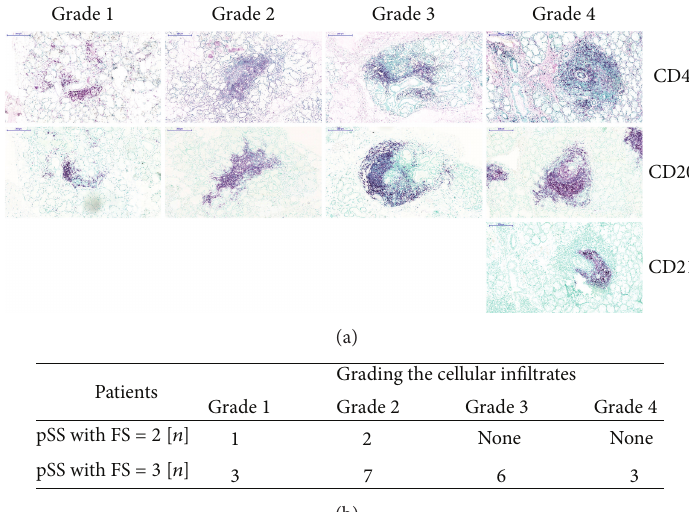
Figure 1: The classification of periductal inflammatory infiltrates with different levels of organization. (a) Immunohistochemical stainings of FFPE sections from representative examples of LSG sections. For rating the periductal lymphocytic infiltrates, paraffin specimens were stained for CD4, CD20, and in some cases CD21. We distinguished four different grades. Grade 1 displayed scattered T and B cells around the ducts. Grades 2 and 3 showed mild and more organized lymphocytic aggregates. Grade 4 indicated a highly organized structure with extensive FDC network in the center. The magnification of digitalized slides is 10x. Scale bar 200 𝜇 m. (b) Distribution of different organizational levels in patients with pSS. 𝑛 : number of biopsy specimens contained at the stage of